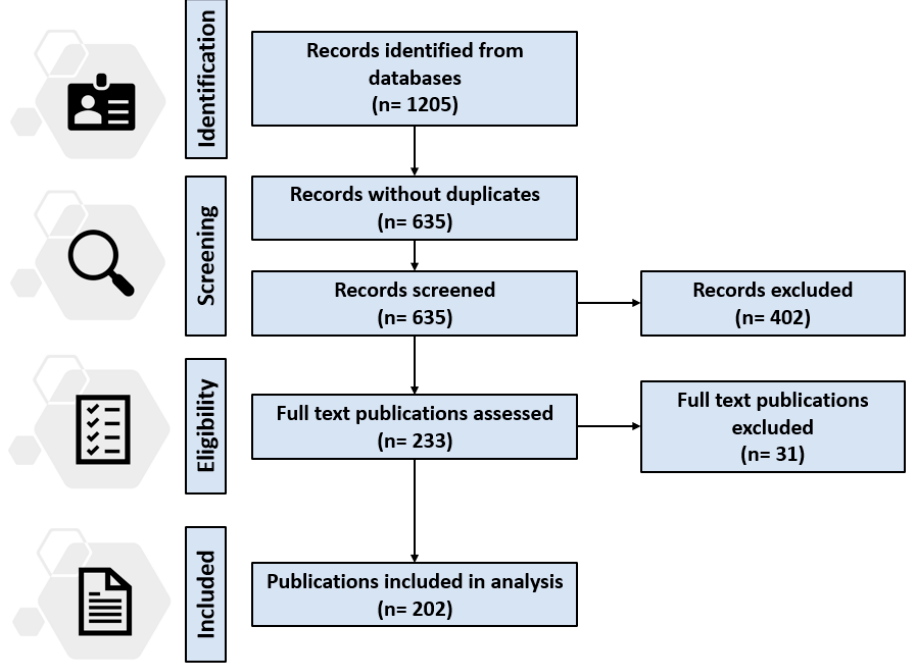
Figure 1. The flow of information during selection of studies according to the PRISMA model comprising Identification, Screening, Eligibility and Inclusion phase.